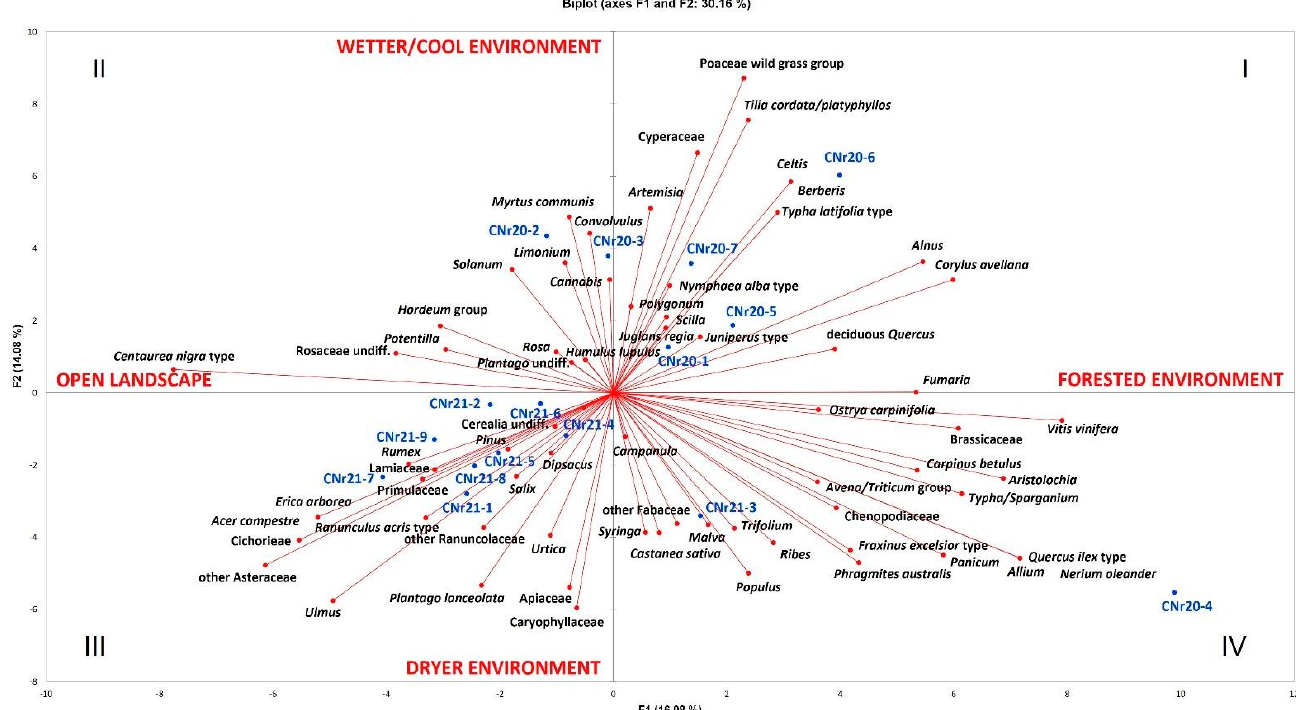
Figure 6. Colombare di Negrar: Principal Component Analysis (PCA) of pollen data from the two trenches (5 and 4). The first component separates pollen spectra along a forestation gradient from an “open landscape” to a “forested environment”, and the second one along a climatic gradient from a drier to a wetter and cool environment.